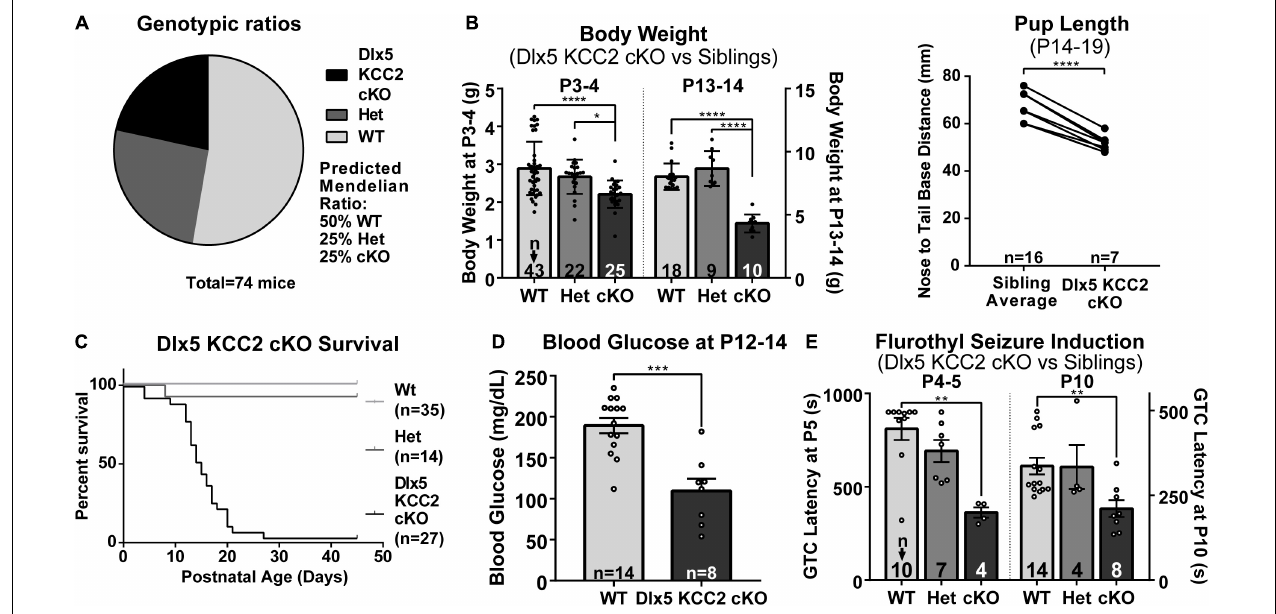
FIGURE 4 | Dlx5 KCC2 cKO mice exhibit failure to thrive and seizures. (A–C) Graphs showing that Dlx5 KCC2 cKO pups are born at expected 25% Mendelian ratio (A) , but have decreased weight and length (B) , and die in the postnatal period (C) . One-way ANOVA with Sidak’s multiple comparisons: *P < 0.05, ****P < 0.0001. For body length, paired comparisons against an average of matched littermate lengths were done using a ratio paired T-test, ****P < 0.0001. (D) Mild hypoglycemia in Dlx5 KCC2 cKO pups. T-test: ***P < 0.001. (E) Susceptibility of Dlx5 KCC2 cKO pups to faster onset of flurothyl-induced generalized tonic clonic seizures (GTC) at P4–P5 and P10. Kruskal–Wallis non-parametric ANOVA: **P < 0.01. The number of mice examined is indicated by n values in each panel. For bar graphs, these are listed at the bottom of each